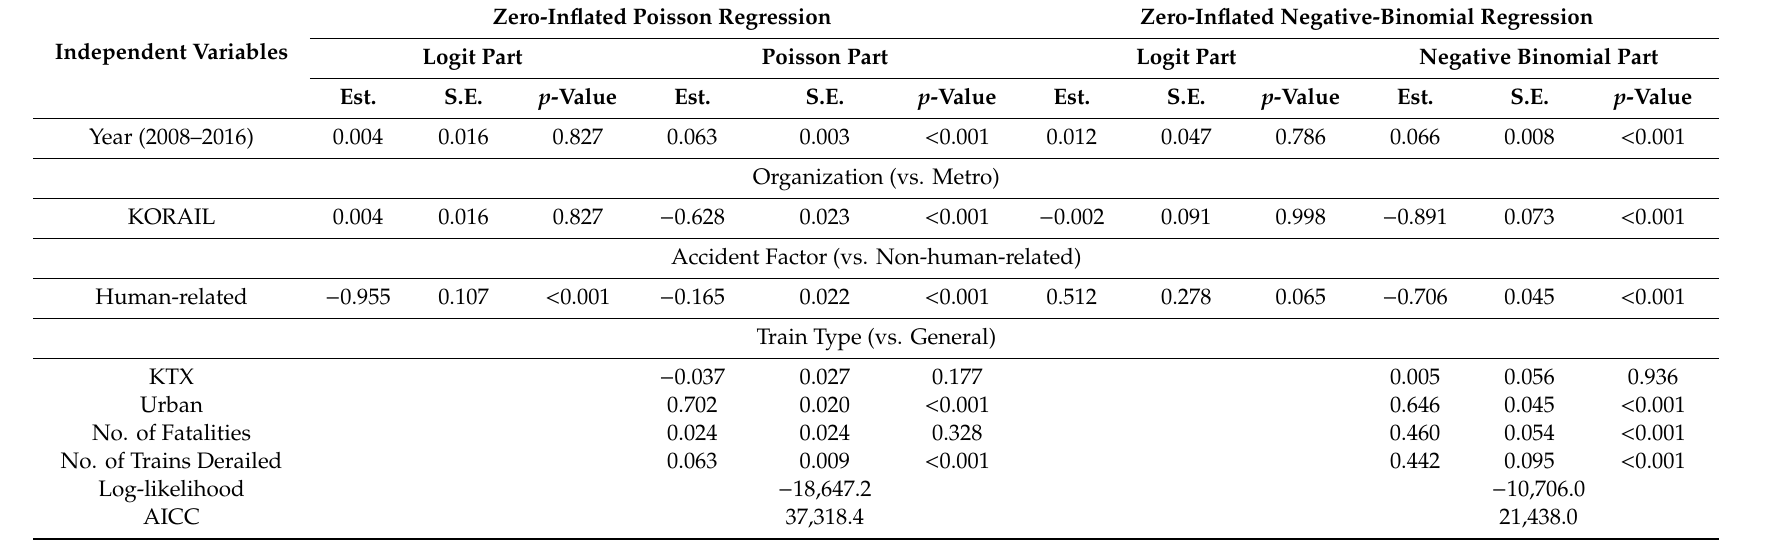
Table 4. Two-Part Regression Analyses of Number of Trains delayed due to Railway